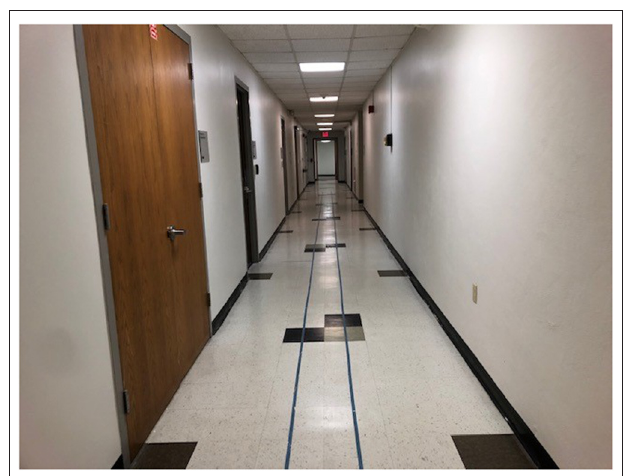
FIGURE 1 | Experimental setup of the walking path which was 60 feet long and 12-inches wide. Photograph used with